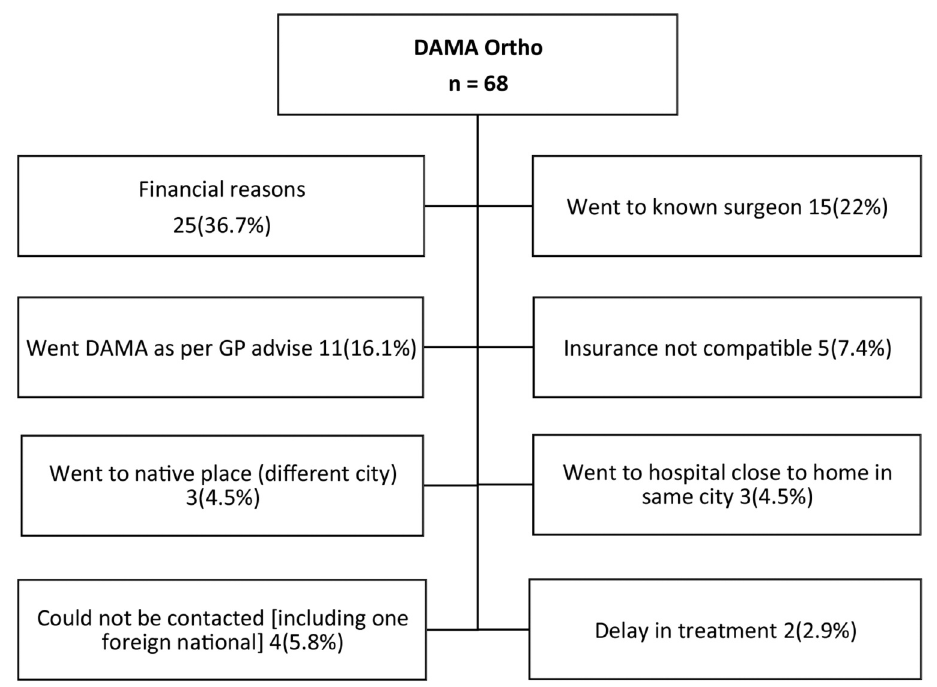
Reasons for discharge against medical advice (DAMA). Fig. 2: